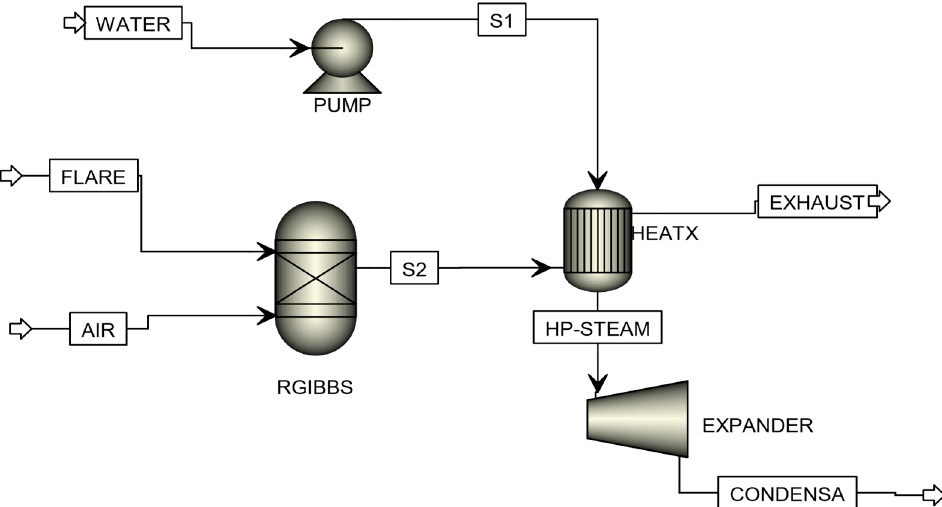
Figure 10. Representation of power generation flowsheet.